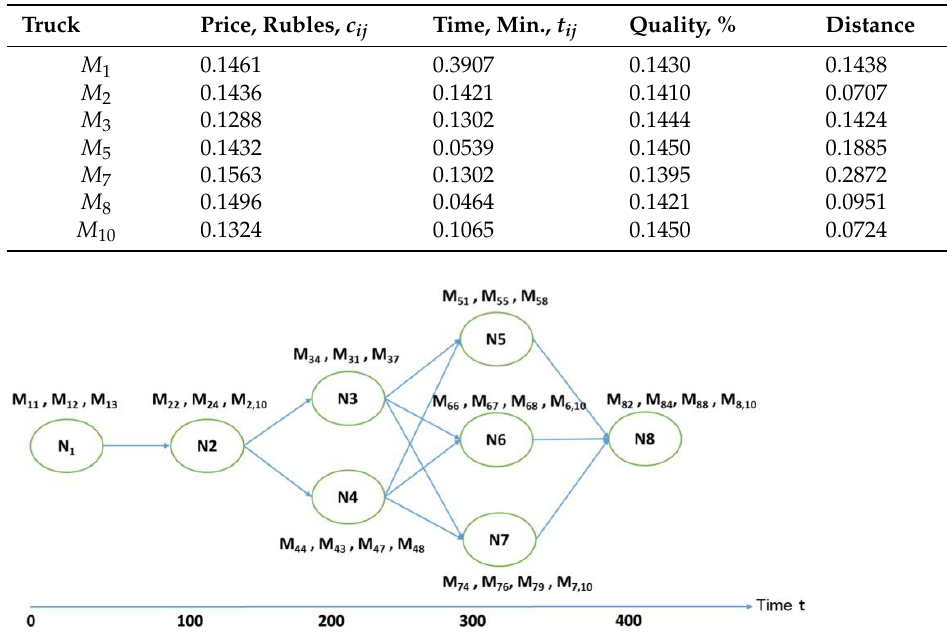
Table 2. Normalized parameters of DP complex of trucks.